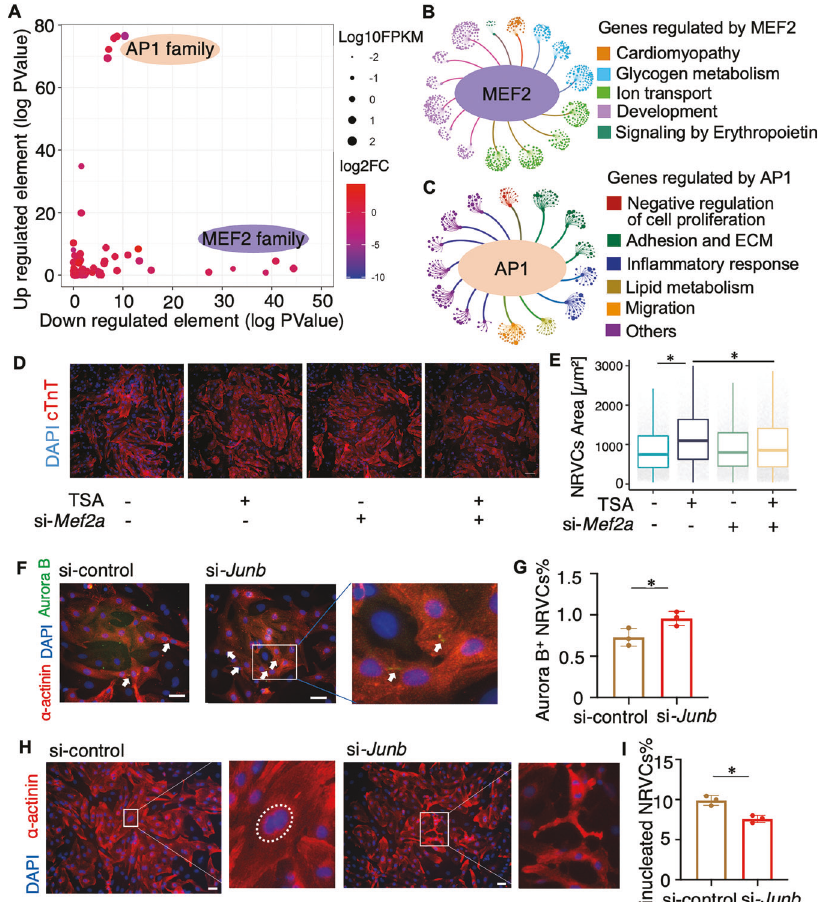
associated with the genes regulated by MEF2 ( B ) or AP1 ( C ). Each node set represents a term and each node in the set represents a gene. The colors of node sets represent the term category. D Co-staining of cTnT and DAPI staining of NRVCs treated with TSA/si-Mef2a ( – / – , + / – , – / + , + / + ). Scale bars, 100 μ m. The representative image is shown. E Quanti fi cations of cell area (Wilcoxon rank sum test, P for TSA/si- Mef2a ( – / – ) vs. ( + / – ) and ( + / – ) vs. ( + / + ) are <2.2E-16, <2.2E-16, respectively. * indicates P < 0.05). F Co-staining of α -actinin and Aurora B of NRVCs treated with scramble siRNA or si- Junb . Scale bars, 100 μ m. The representative image from one of three independent experiments is shown. G Percentage of Aurora B + NRVCs ( n = 3, two-tailed Student ’ s t -test, P = 0.044, * indicates P < 0.05). H Co-staining of α -actinin and